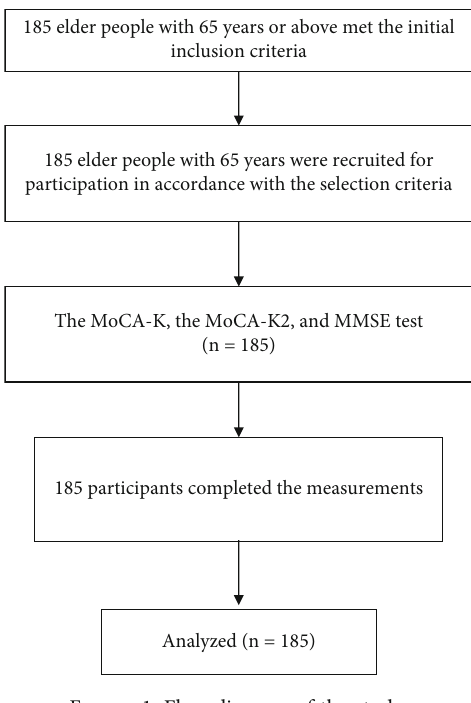
Figure 1: Flow diagram of the